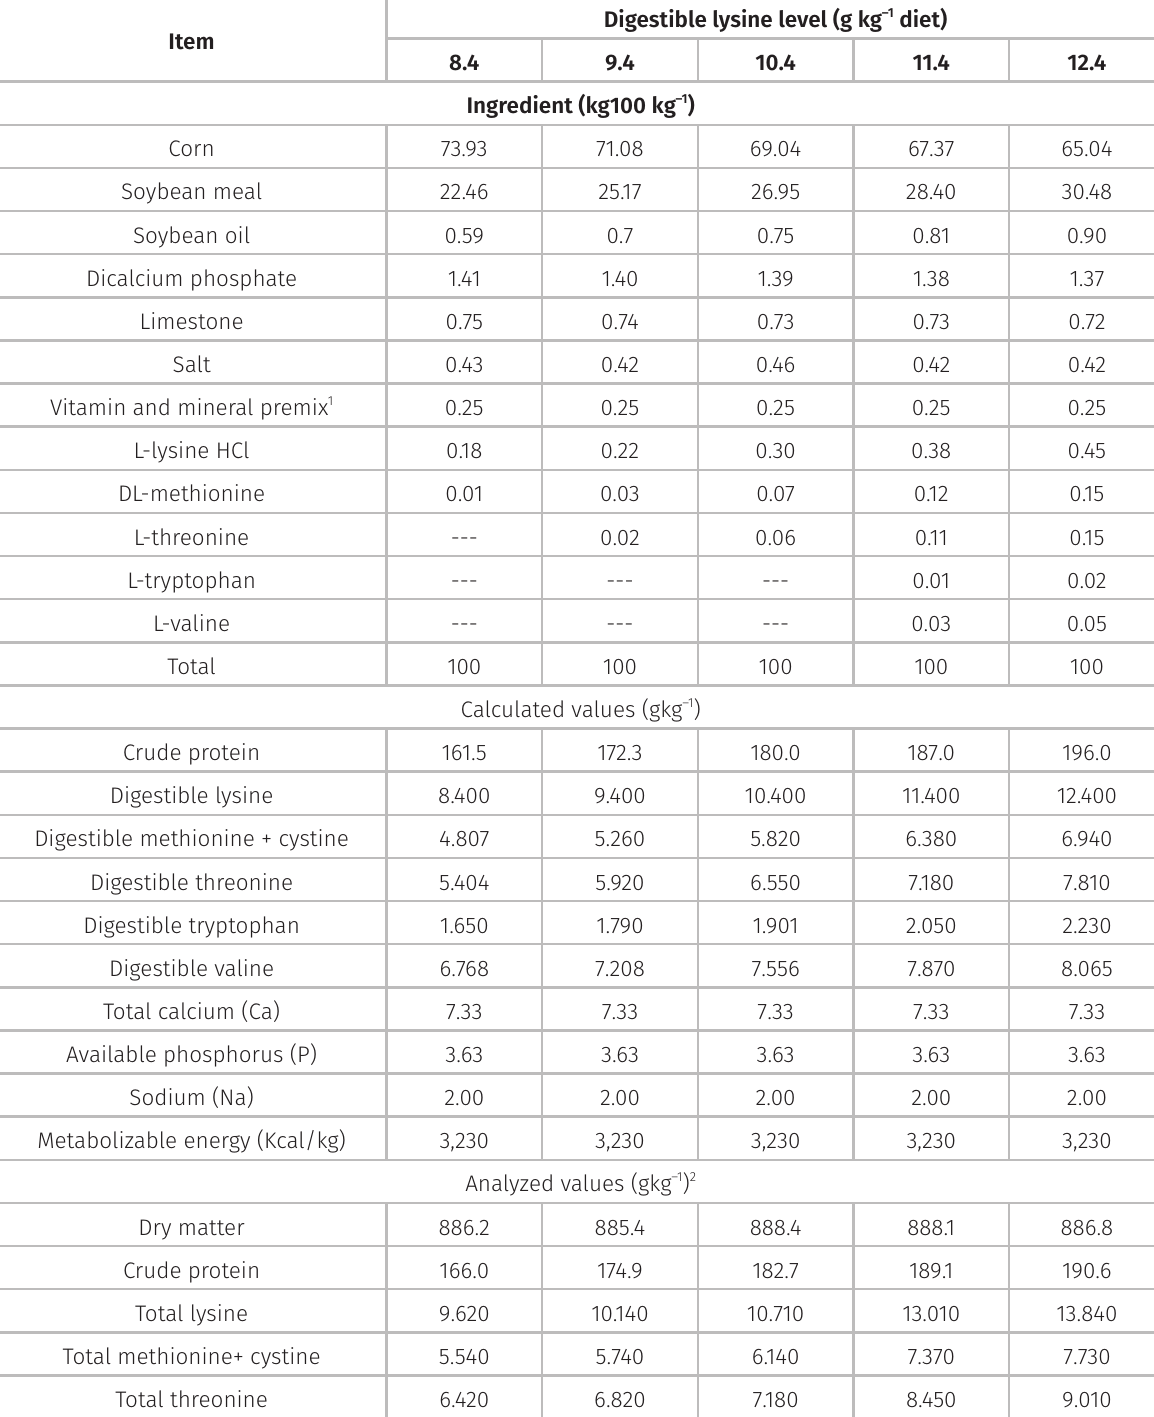
Table I. Centesimal, calculated, and analyzed composition of the experimental diets expressed on an as-fed basis.